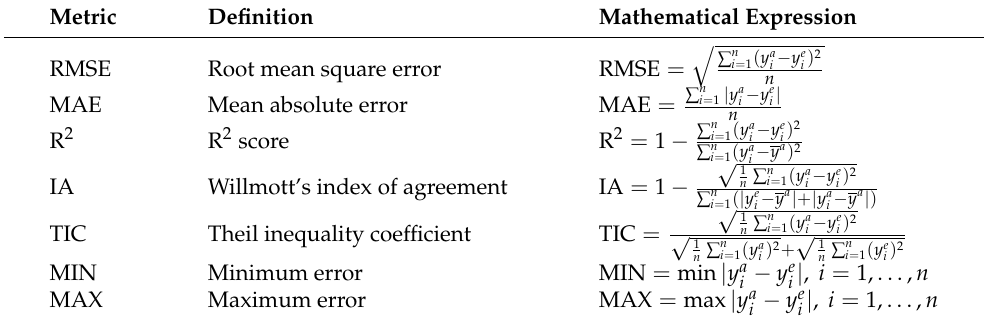
Table 2. Seven evaluation criteria to evaluate the performance of the proposed method.